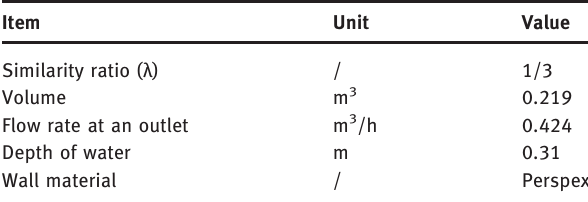
Table 2: The parameters of water model.